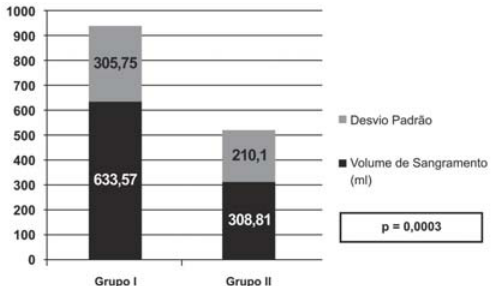
Fig.1 - Volume de sangramento - Grupo I - controle; Grupo II - ácido épsilon aminocapróico